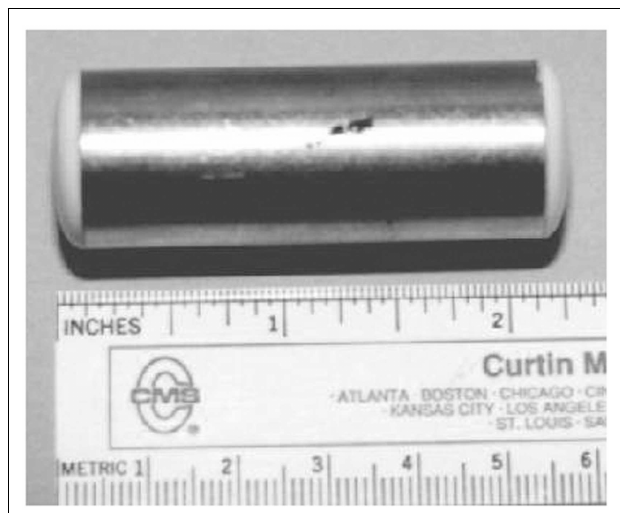
FIGURE 3 | Forestomach temperature measuring telemetry pill